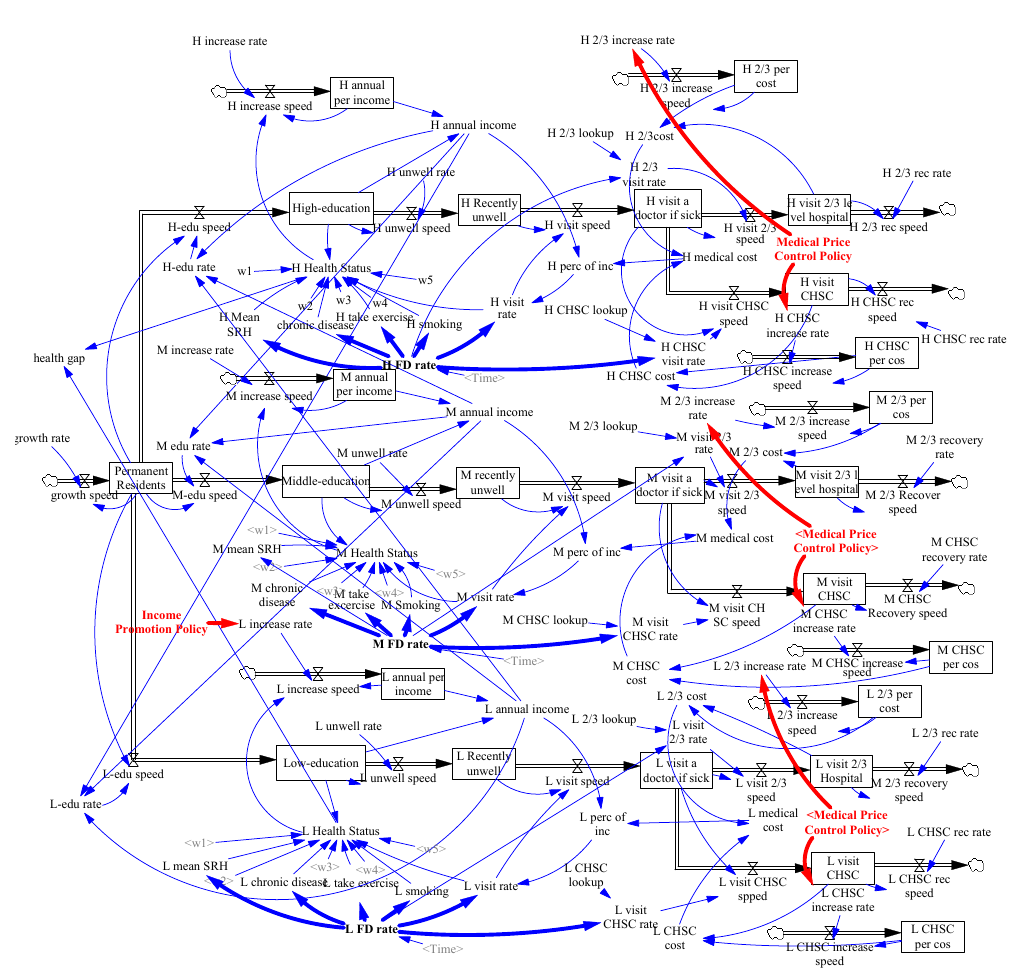
Figure A1. System dynamic model of the FD intervention.